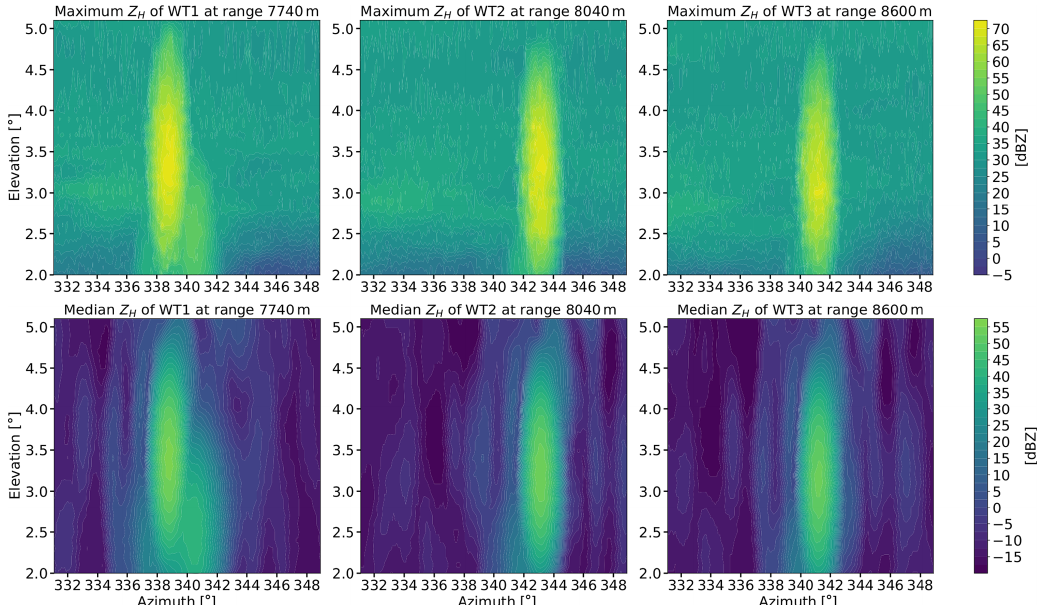
Figure 6. Maximum (first row) and median (second row) fixed-range statistics from PPI radar scan data of horizontal reflectivity Z H for all three observed wind turbines during the entire measurement campaign in March 2019. The first column shows the results for WT1 (range: 7740m), the second column the results for WT2 (range: 8040m) and the third column the results for WT3 (range: 8600m). The elevation angles go up to 5 . 1 ◦ , and the azimuth range is 18 ◦ (see Table 3).